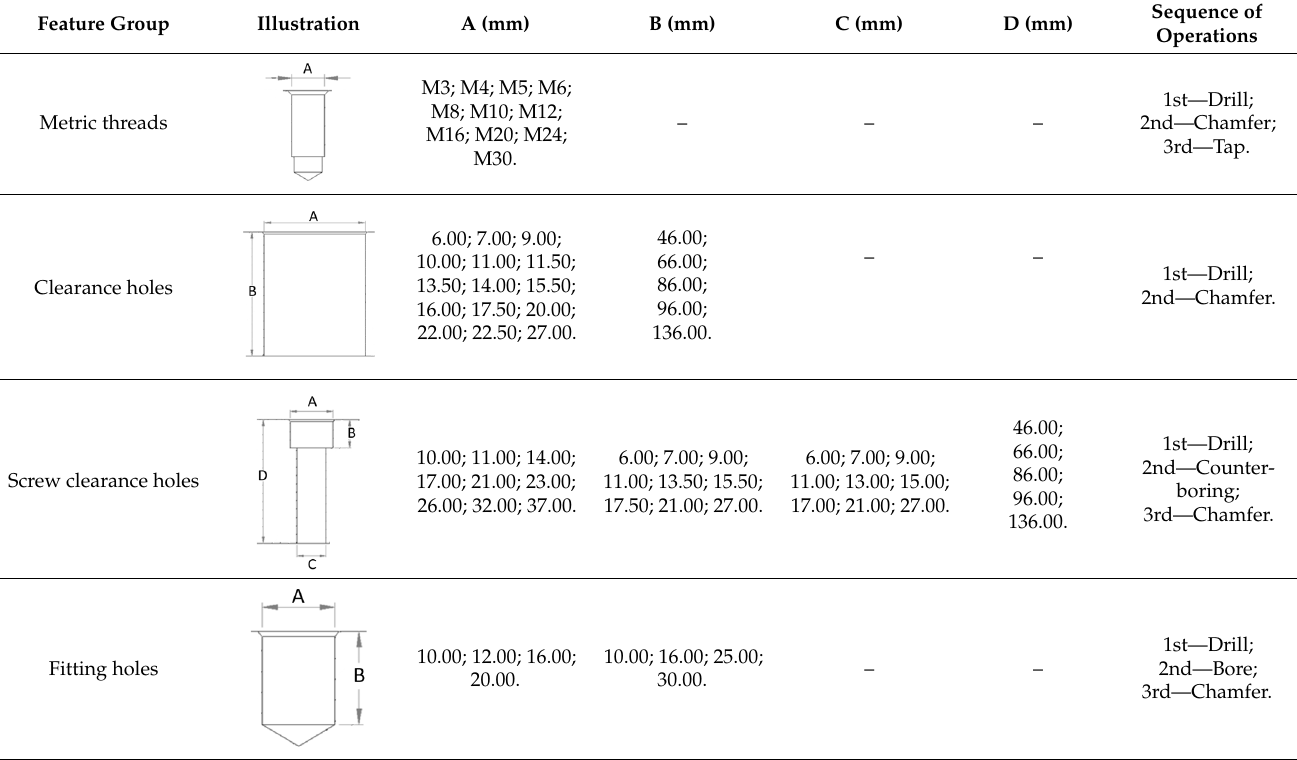
Table 1. Feature definitions and corresponding sequences of operations.